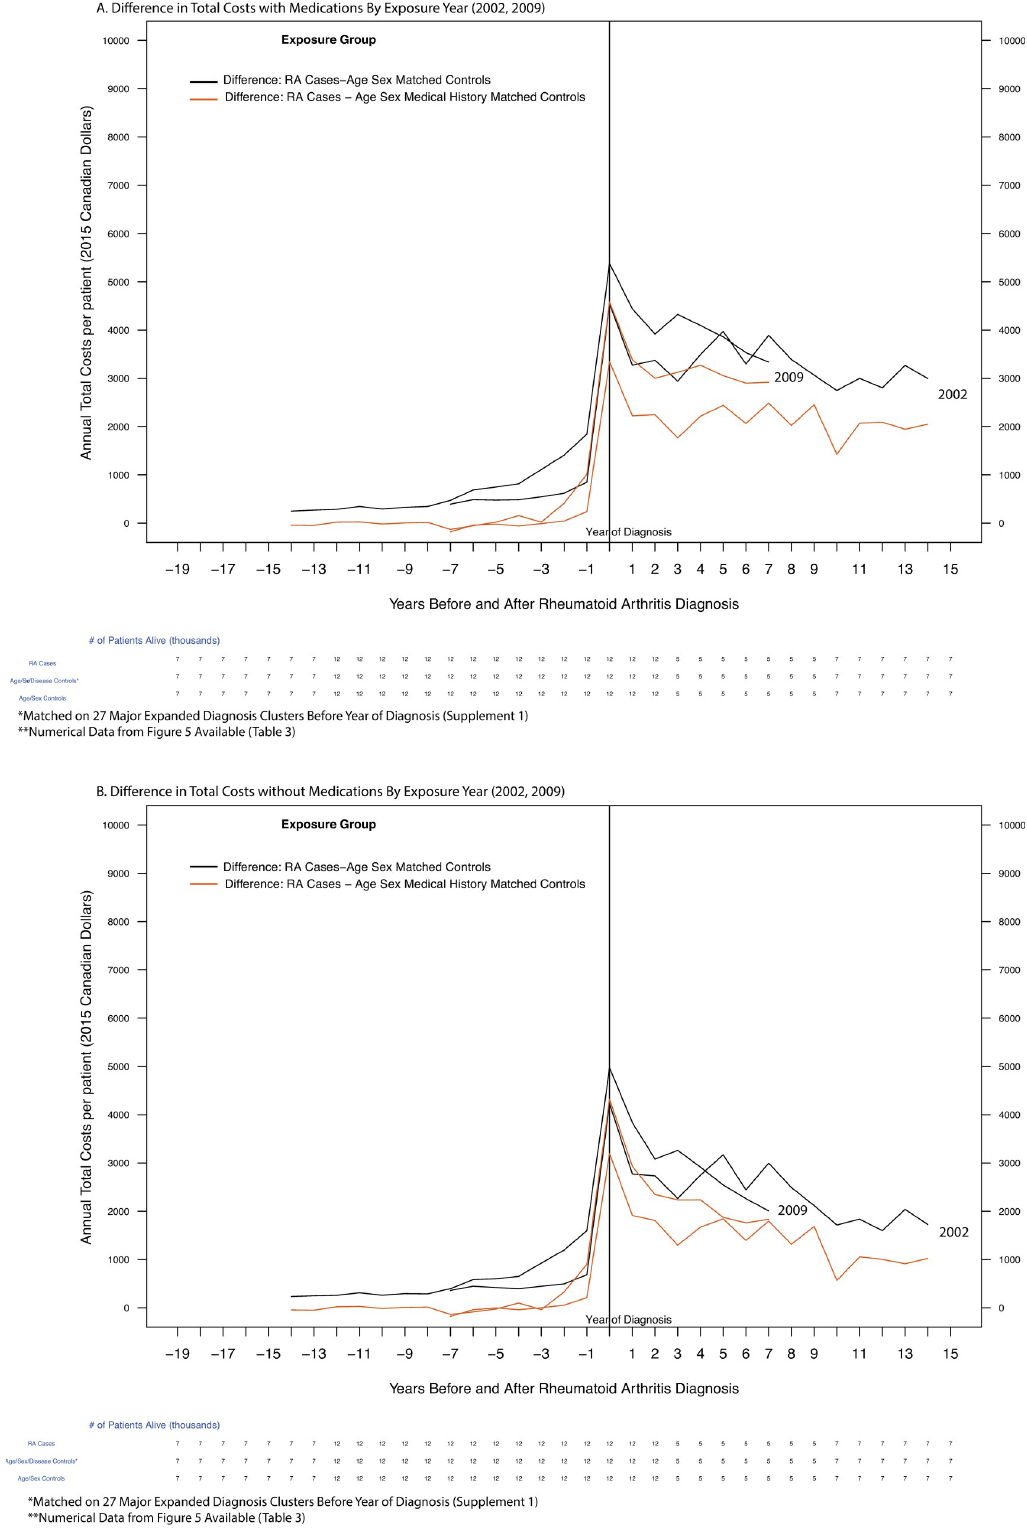
Fig 5. Difference in Annual per-patient health care costs over time grouped by diagnosis year (2002, 2009) before and after rheumatoid arthritis diagnosis (public payer’s perspective). X-axis: Years before and after RA diagnosis, Y-axis: Annual Costs Per Patient (2015 Canadian Dollars), Grouping Variable: Exposure